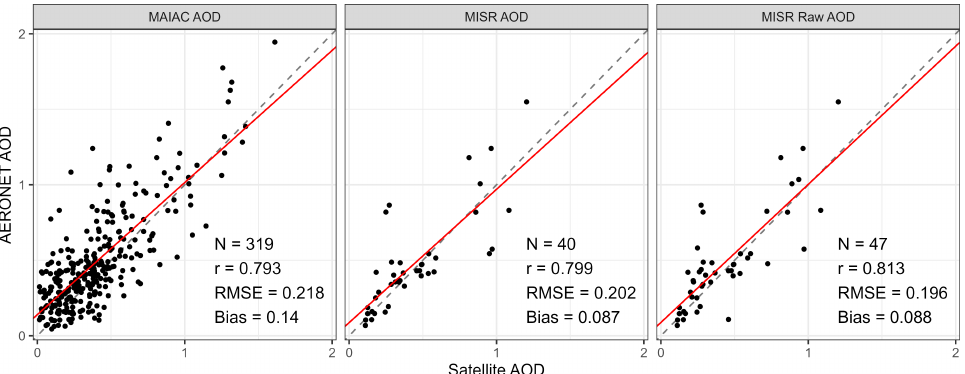
Figure 3. Validation of AERONET AOD interpolated to 550 nm versus MAIAC AOD ( left ), MISR AOD ( center ), and MISR “raw” AOD ( right ) with one-to-one line (dotted) and correlation line (red).